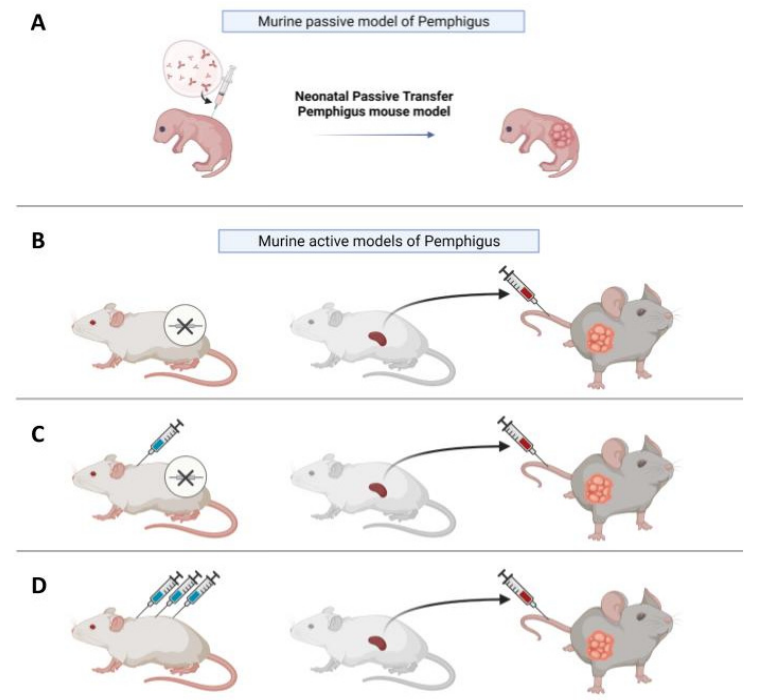
Figure 2. In vivo models of Pemphigus. ( A ) In vivo neonatal passive transfer Pemphigus mouse model. IgG fractions isolated from patients ′ sera (PVIgG), or other engineered anti-desmoglein 3 (DSG3) antibodies, are injected subcutaneously or intraperitoneally into new-born mice. Mice develop blisters in 24–36 h, which show the typical histology observed in patients. ( B ) Active disease model. DSG3 null mice are not tolerant against DSG3 given that DSG3 is never exposed to the immune system. After adoptive transfer of naive lymphocytes from DSG3 null mice, Rag2 − / − immunodeficient mice produce anti-DSG3 IgG antibodies and display traits of PV phenotype. ( C ) Another active disease model is generated by adoptive transfer of splenocytes after repeated immunization with recombinant DSG3 of a DSG3 null mouse. The receiving Rag2 -/- mouse will develop blisters and hair loss because, in mice, intercellular adhesion of follicular epidermis is mainly mediated by DSG3 during the rest phase of hair growth. ( D ) Active model after tolerance breakage in a WT mouse with high doses of antigen. After repeated injections, splenocytes were transferred in Rag2 − / − mice, which would develop